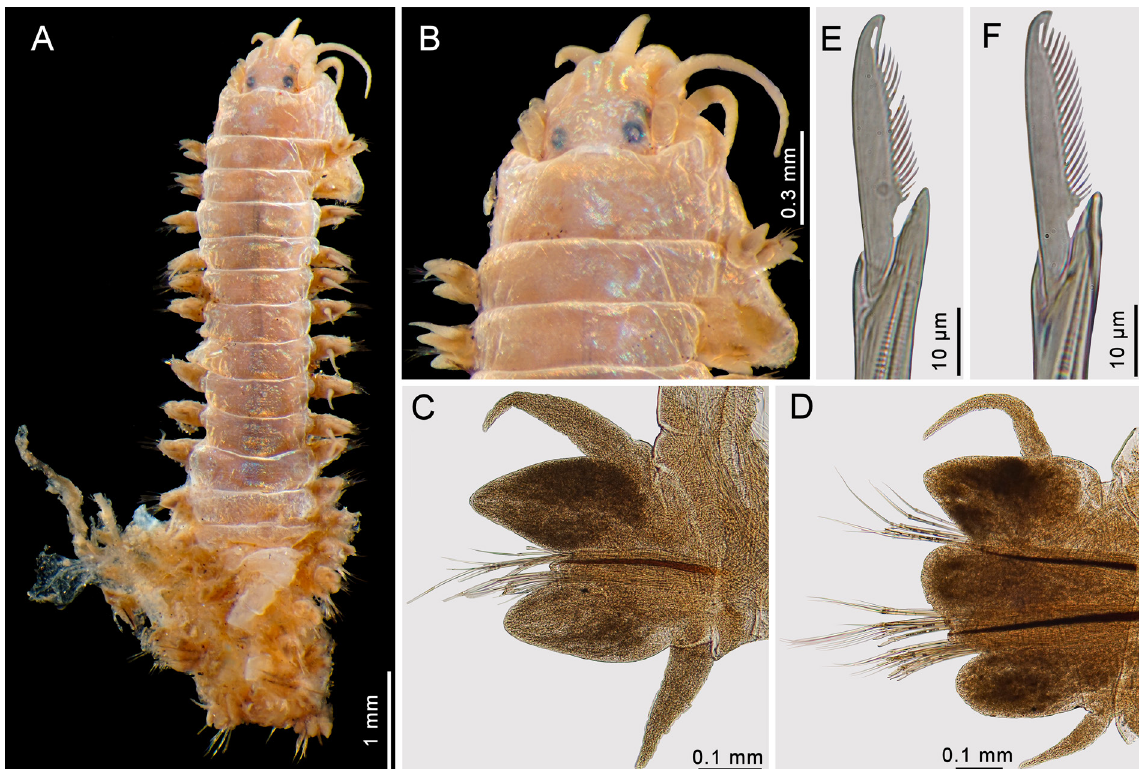
Fig. 11. Nereis riisei Grube & Örsted in Grube, 1857, holotype of Nereis glandulata Hoagland, 1919 (AMNH 1211). A . Anterior fragment, dorsal view. B . Anterior end, dorsal view. C . Chaetiger 2, right parapodium, anterior view. D . Chaetiger 9, right parapodium, anterior view. E . Same, neuropodial supracicular heterogomph falciger. F . Same, neuropodial subacicular heterogomph